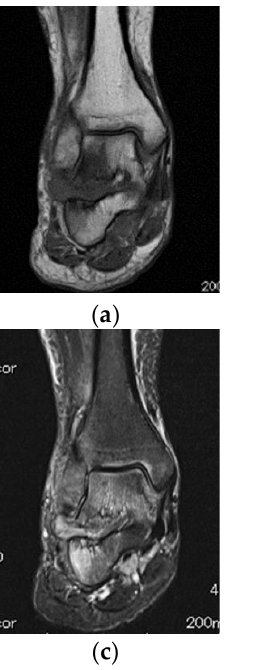
Figure 2. Subtalar joint showing progressive involvement 1 year later. Coronal T1-weighted ( a ), sagittal T1-weighted ( b ), coronal fat-suppressed T2-weighted ( c ), and sagittal fat-suppressed T2- weighted ( d ) images of the right ankle joint. Findings show a marked loss of articular cartilage with associated bone marrow edema in the subarticular region of the subtalar joint and bone marrow edema of the tibiotalar joint.